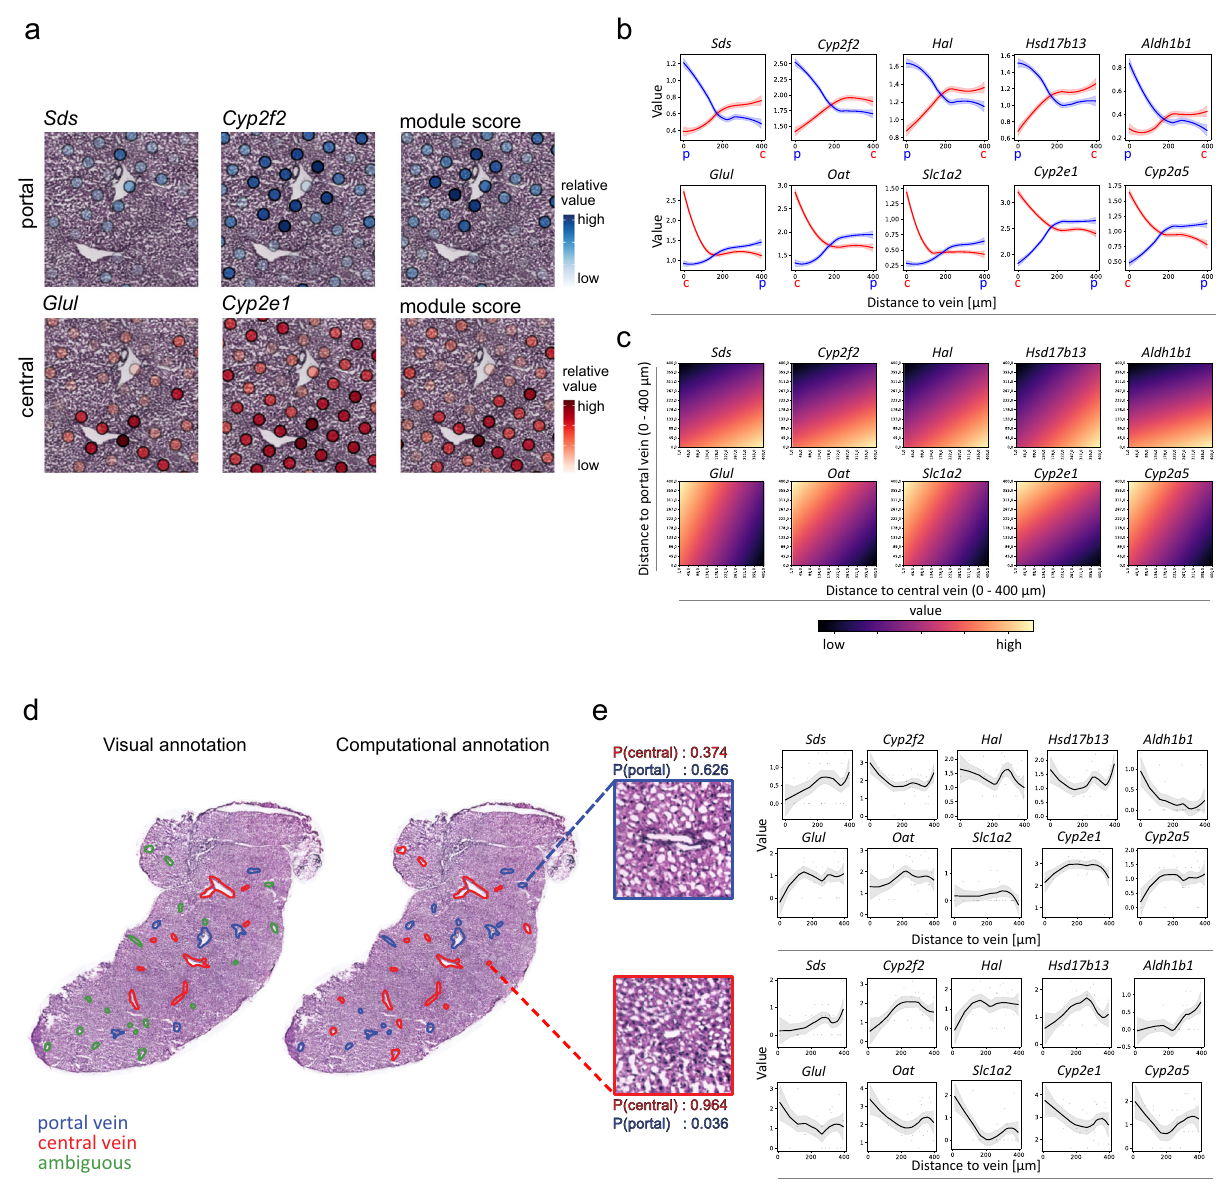
Fig. 3 Expression gradient along the lobular axis and computational annotation of liver vein types. a Enlarged view of a superimposed visualization of Sds , Cyp2f2 expression in the portal vein module, consisting of selected DEGs of cluster one (Supplementary Dataset 1), all with high values around the histological annotation of a portal vein (top). Expression of Glul , Cyp2e1 as representative marker-genes of the central vein module expression (Supplementary Dataset 1), consisting of DEGs of cluster 2 with high values around the histological annotation of a central vein (bottom). b Visualization of the average expression by distance to vein-type measured within 400 µ m from the vein. The top row shows expression by distance of portal markers Sds, Cyp2f2, Hal , Hsd17b13 and Aldh1b1 to portal veins in blue and central veins in red, while the bottom row shows distances of central vein markers Glul, Oat, Slc1a2, Cyp2e1 , and Cyp2a5 to portal veins in blue and central veins in red (top panel). Red and blue ribbons around the fi tted line represent the standard error of the gene expression within spots along the distance to respective vein type. c Visualization of in fl uence of distance to both vein types on expression by bivariate expression by distance plots (Methods). Gene expression values are depicted in a gradient from low (dark) to high values (light). The distance of each gene to central veins between 0 and 400 µ m is represented on the x-axis. Simultaneously, distances to portal veins for the same distance are depicted on the y-axis for each gene. High values in the bottom right corner indicate gene expression is predominantly observed close to portal veins and far from central veins, while high values in the upper left corner indicate the reverse observation (below graphs). d Visual histological annotations (left) of central (red) and portal (blue) veins, including ambiguous visual annotations (green), compared with computational prediction, using the 10 marker genes from b (right). The classi fi cation of vein types is based on a weighted (by distance) average expression of the genes ’ expression pro fi les in the neighborhood of each vein. In addition, the spatial expression data of spots neighboring uncertain morphological vascular annotations (green) can be used to predict periportal or pericentral vein types in the cases where visual annotations are ambiguous. e Expression by distance of portal — (top panel) and central — (bottom panel) markers. Probabilities for each class (central and portal) can be extracted from the logistic regression model, here given as P(central) or P(portal) (scale bar indicates 500 µ m). Grey ribbons around the fi tted line represent the standard error of the gene expression within spots along the distance to each of the depicted